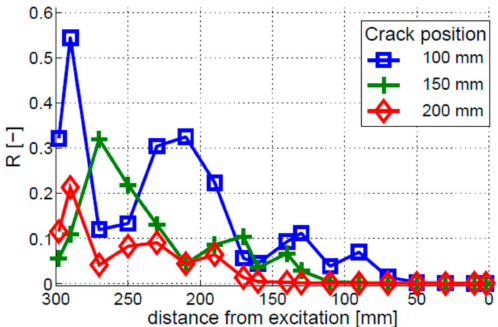
Figure 8. Crack localization effect for the bi-linear crack model. Three different single-crack locations are investigated, i.e., the cracks positioned 100, 150, and 200 mm away from the free end of the